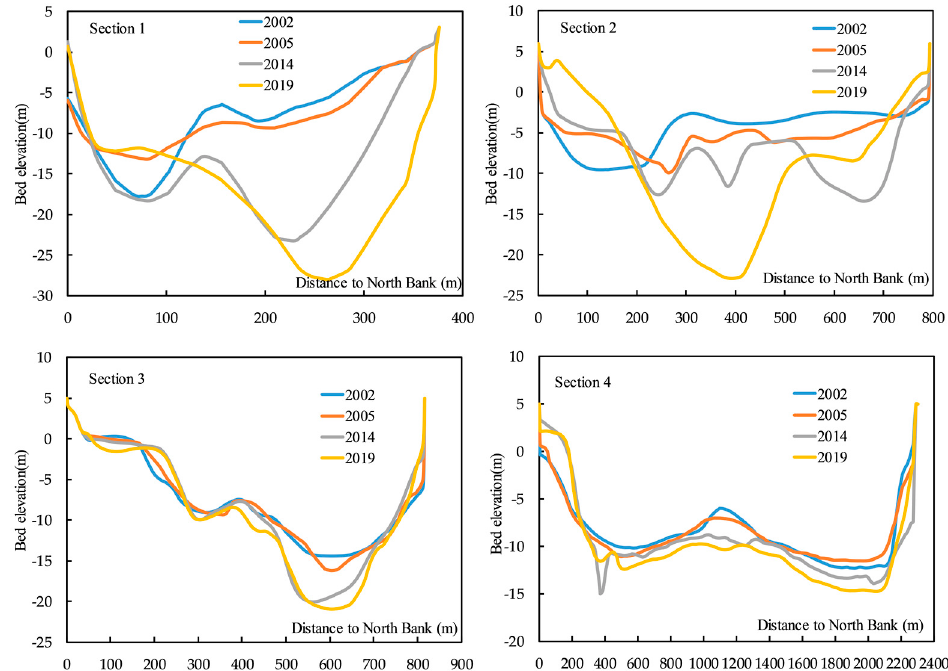
Figure 8. Erosion and deposition change of a representative section.